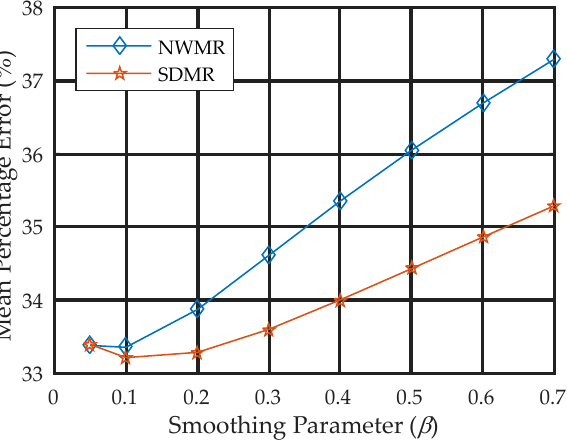
Figure 8. MPE-versus-smoothing parameter curves for NWMR and SDMR.